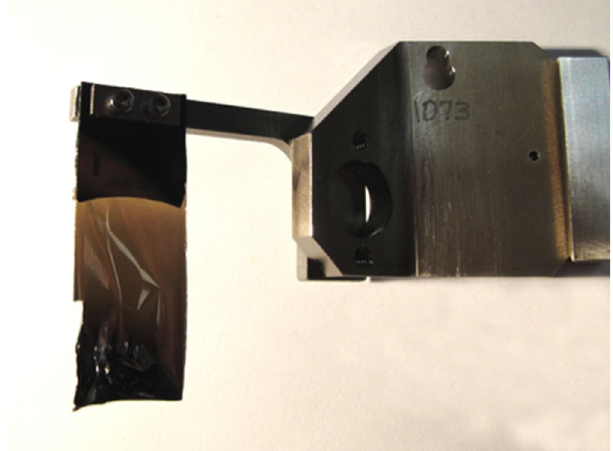
FIG. 9. Photo of the fourth generation foil and bracket that lasted the entire September to December 2009 run cycle at high beam power. (The figure was reproduced from Ref.